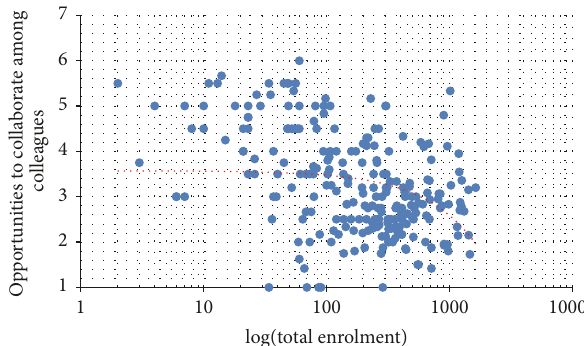
Figure 2: Teacher opportunity to collaborate with colleagues by school